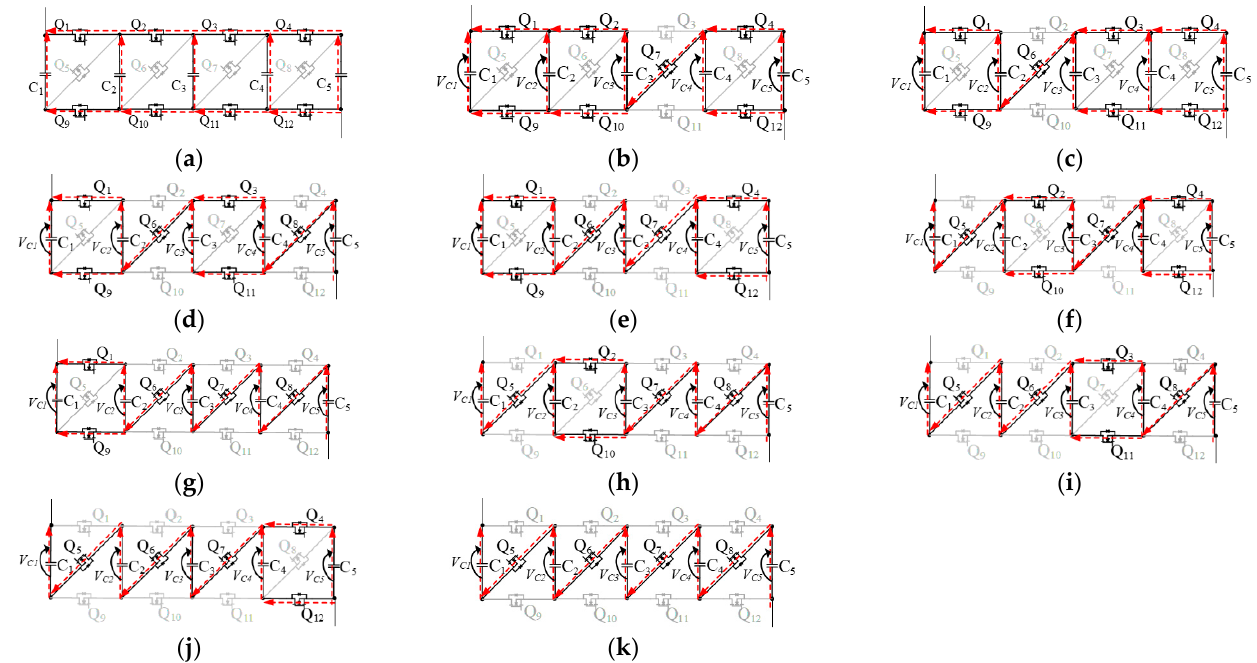
Figure 10. Operation modes. ( a ) Mode 1 (1S-5P), ( b ) substate 2A, ( c ) substate 2B, ( d ) substate 3A, ( e ) substate 3B, ( f ) substate 3C, ( g ) substate 4A ( h ) substate 4B, ( i ) substate 4C, ( j ) substate 4D, ( k ) mode 5 (5S-1P).